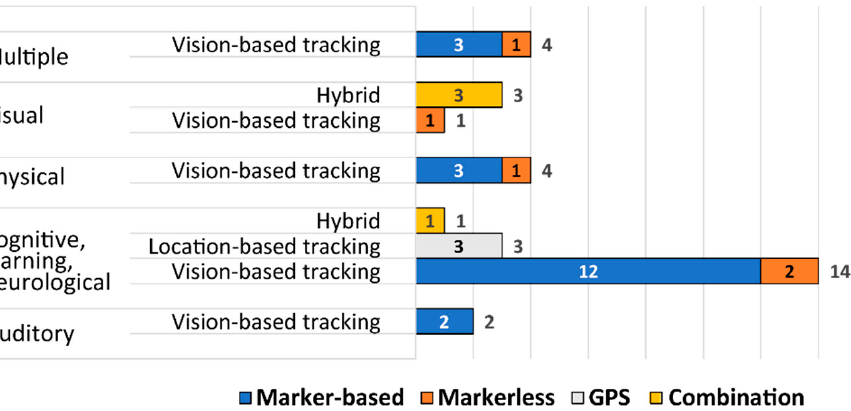
Figure 3. Distribution of AR handheld solutions by the disability type and type of tracking technology used in the solution.